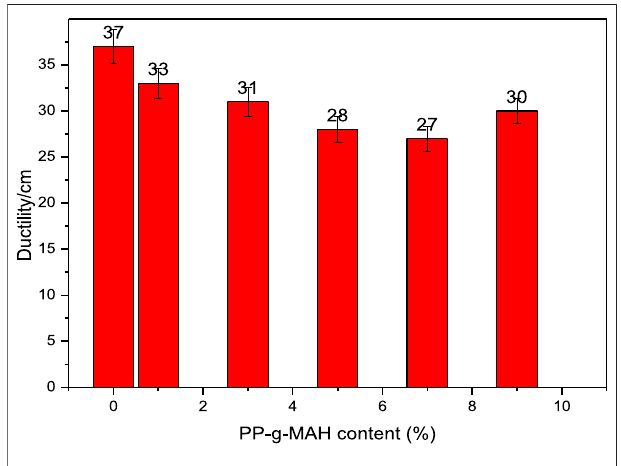
FIGURE 4 | Effect of PP-g-MAH content on the ductility of modi fi ed